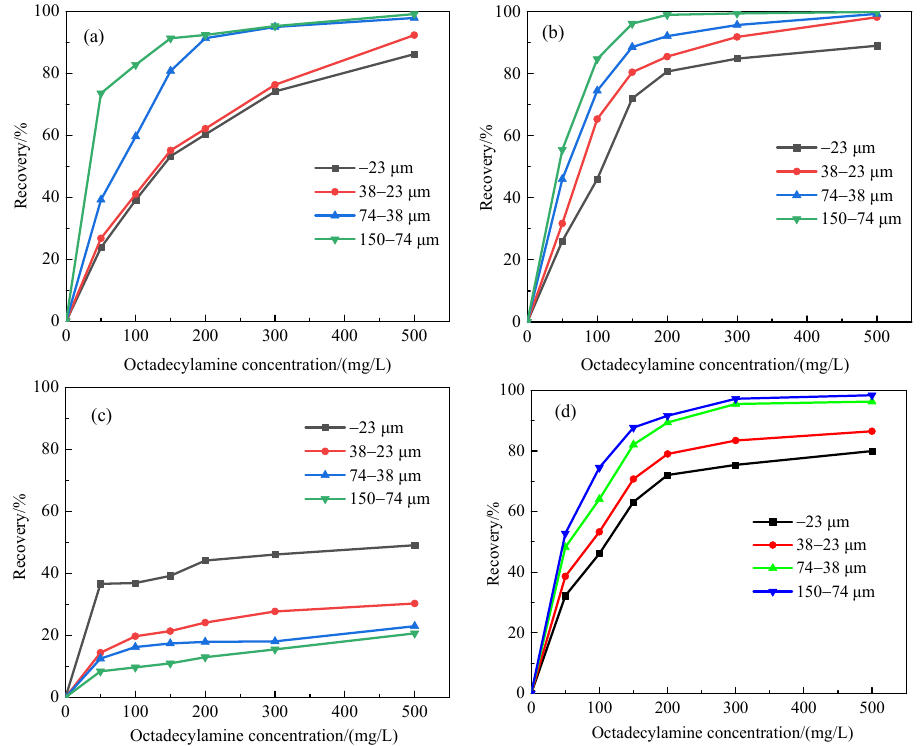
Figure 9. The floatability of ( a ) smithsonite, ( b ) quartz, ( c ) kaolinite, ( d ) calcite using octadecylamine concentration: 150 mg/L at pH 9.5−10 and 28.57% solid concentration.